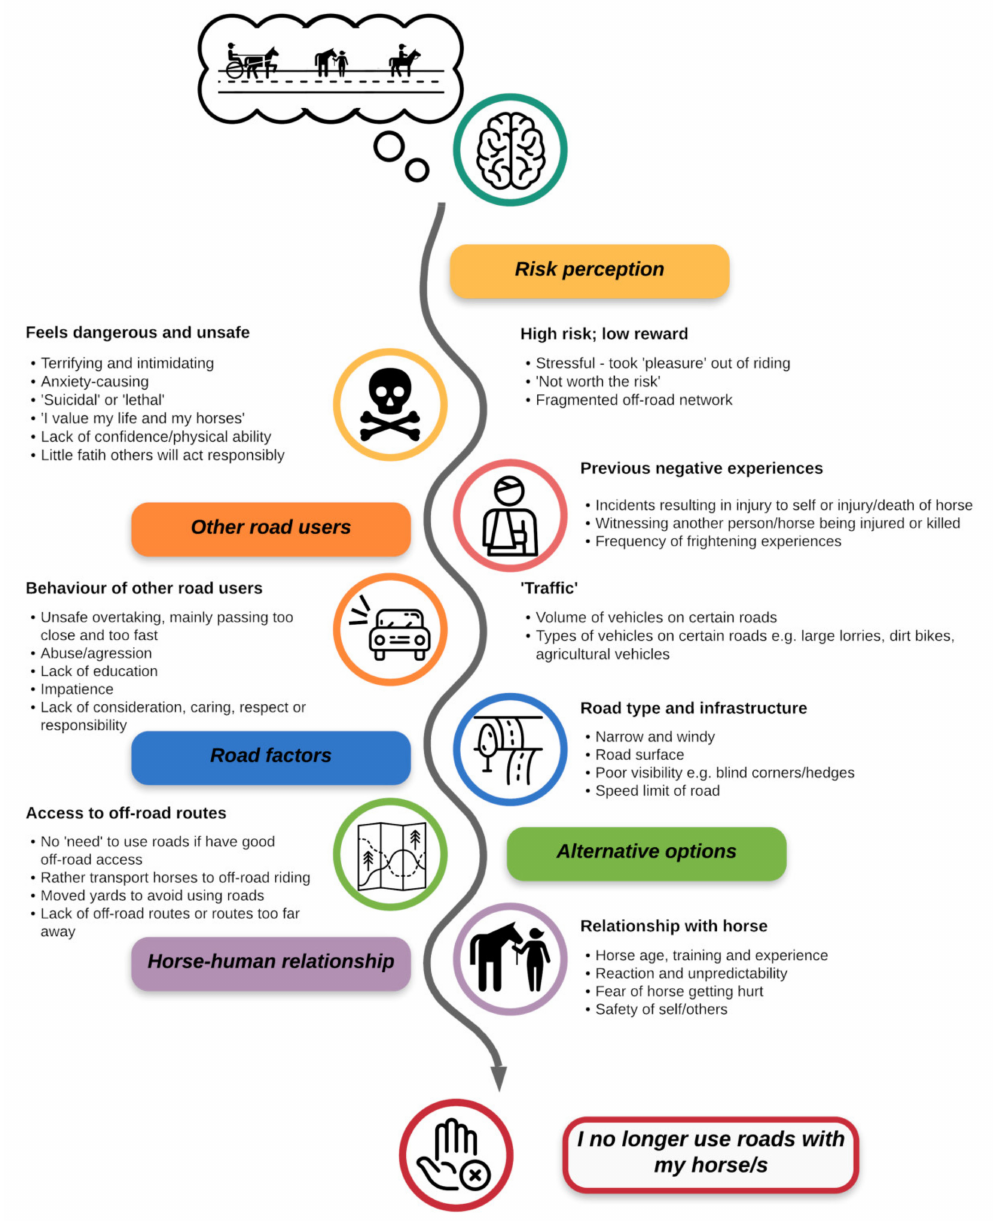
Figure 5. A depiction of the categories and themes which contribute to UK equestrians’ decisions to no longer use roads with their horses, based on each specific horse-human dyad and